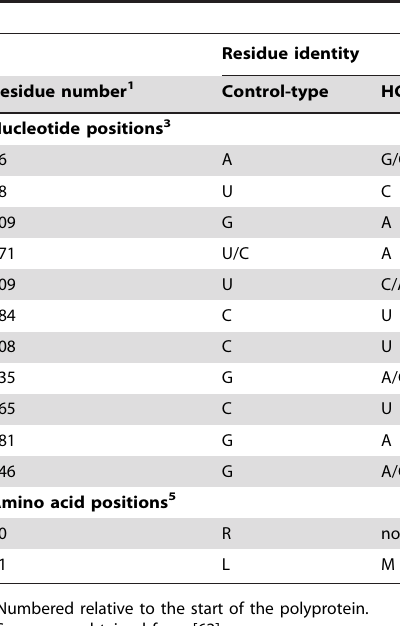
Table 5. Positions in core associated with HCC.